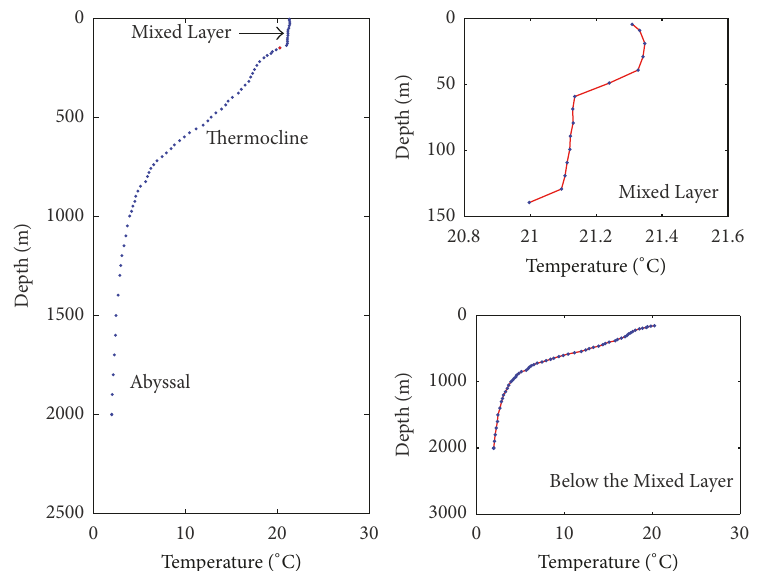
Figure 1: Strategy to divide the Argo measure points: the red dot represents the estimation of the MLD.